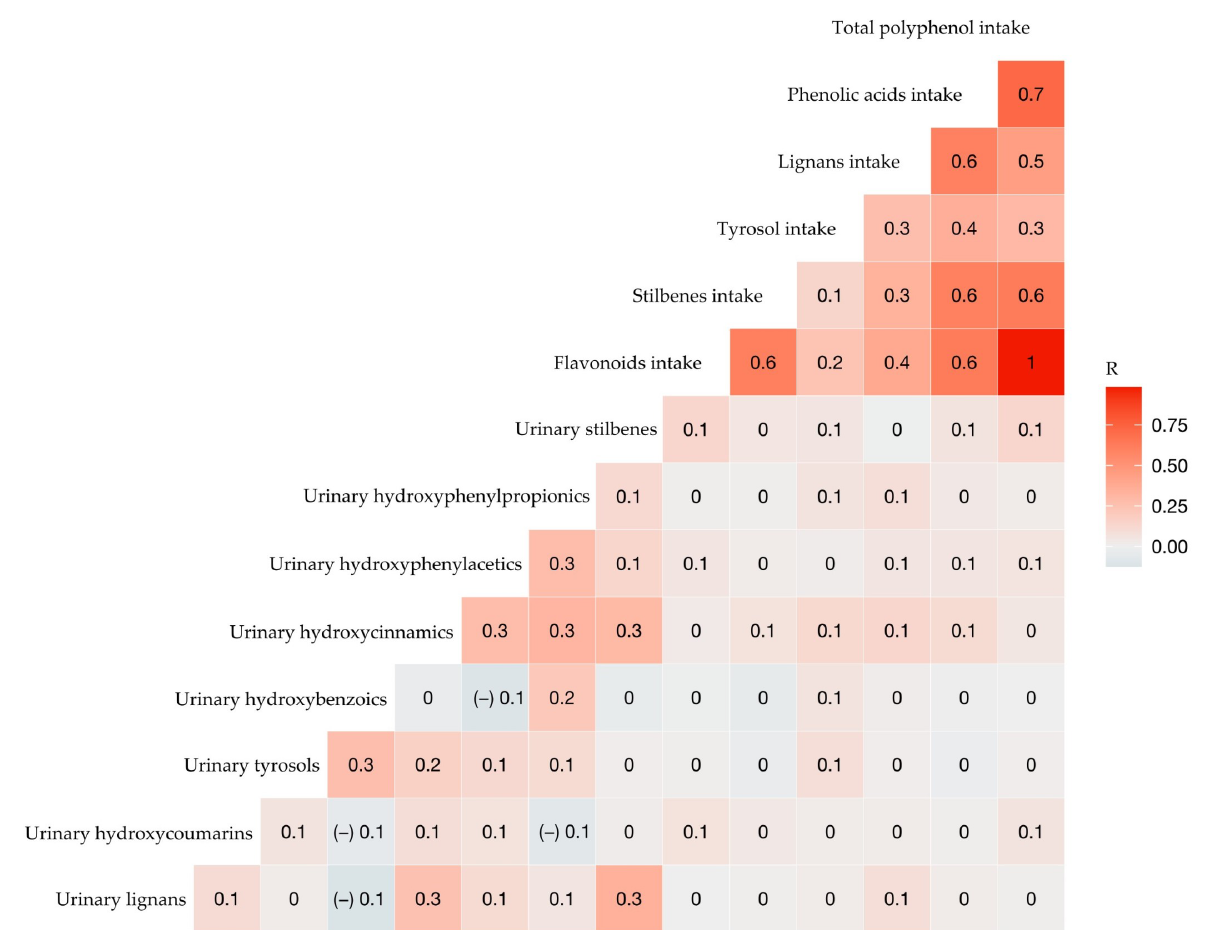
Figure 2. Heatmap of the Pearson correlation between subclasses of urinary MPM and energy- adjusted (poly)phenol intake in adolescents.